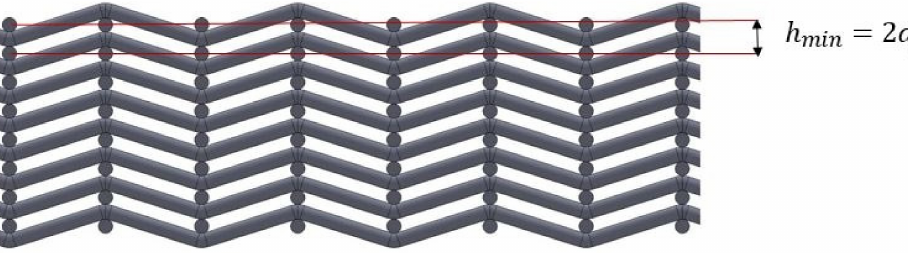
Figure 4. Front view of inline stacking type-a for closely packed scenario (with h min spacing).